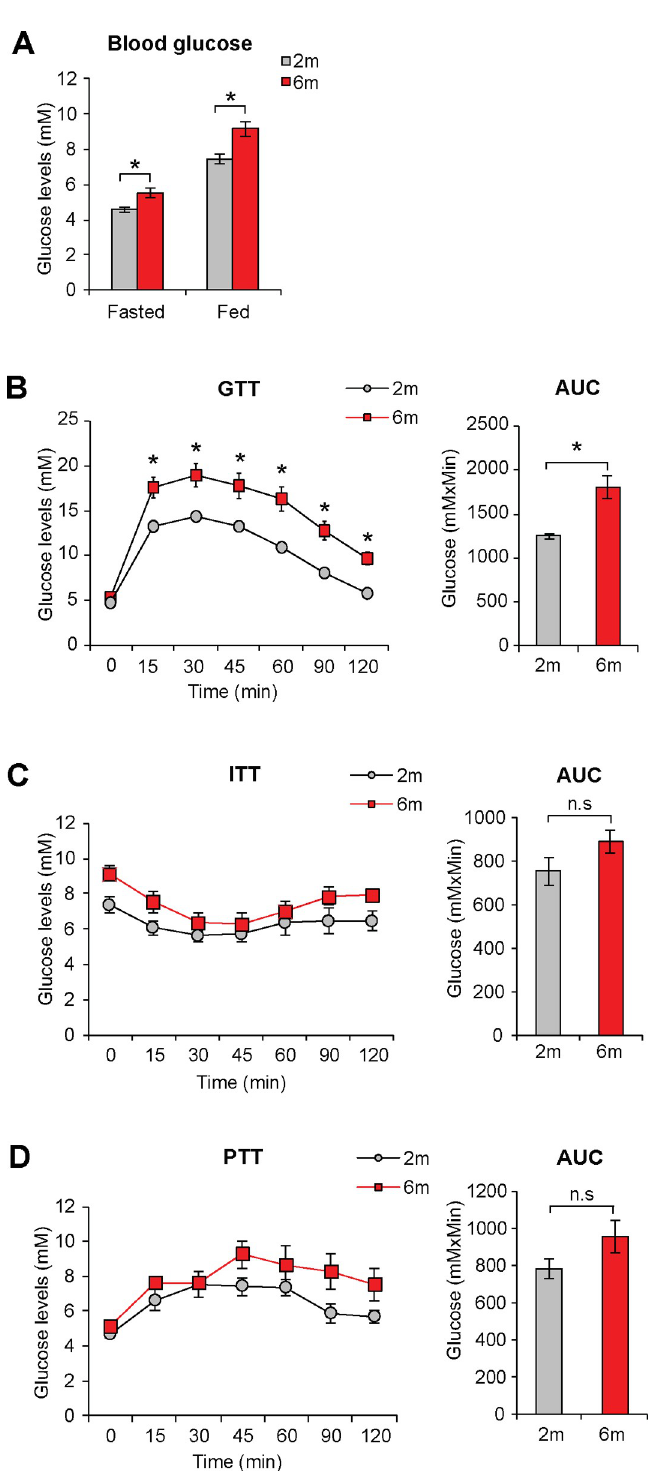
Fig 2. Alteration of glucose metabolism during early adulthood. (A) Blood glucose quantification in 2 and 6 months old mice measured in overnight fasted and fed state. (B) Glucose tolerance test (GTT) and area under the curve (AUC) quantification in 2 and 6 months old mice. (C) Insulin tolerance test (ITT) and area under the curve (AUC) quantification in 2 and 6 months old mice. (D) Pyruvate tolerance test (PTT) and area under the curve (AUC) quantification in 2 and 6 months old mice. Results are average ± SEM (n � 5), � p < 0.05.